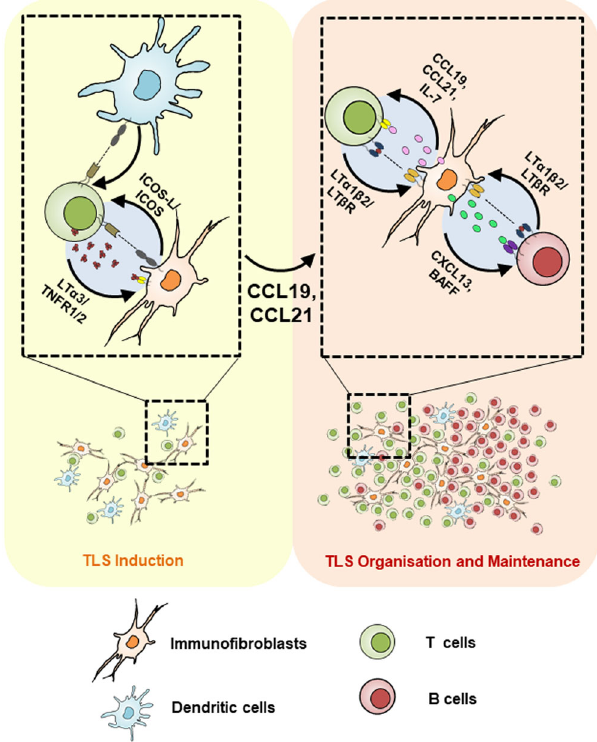
Fig. 6 Model of immuno fi broblast- T cell cross-talk via ICOSL/ICOS engagement in TLS formation. During in fl ammation in a non-lymphoid organ, activated resident immuno fi broblasts and DCs upregulate ICOSL, which interacts with the locally recruited ICOS + T cell contributing to their secretion of LT α . Engagement of LT α 3 with TNFR1/2 on immuno fi broblasts induces CCL19 and CCL21 chemokine production that is crucial for the positive feedback loop involved in TLS